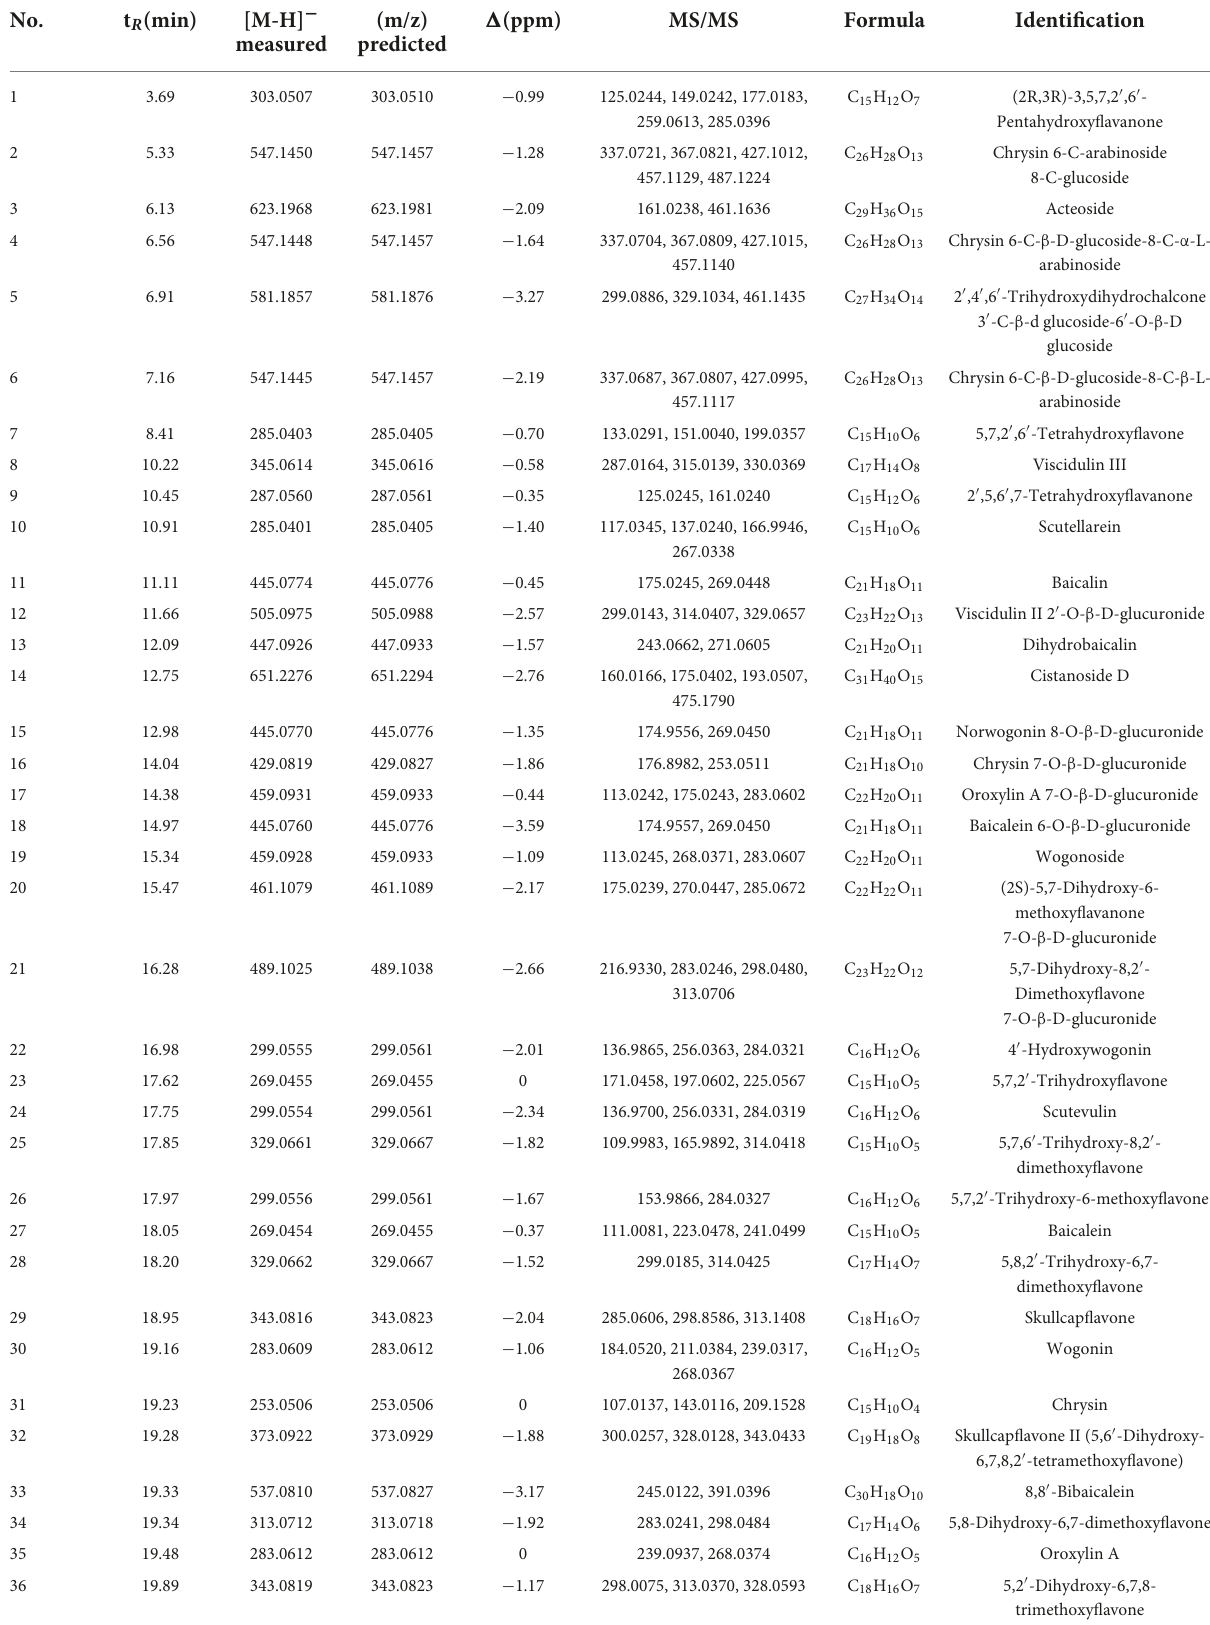
TABLE 1 Identification of compounds from Scutellariae radix extract by UHPLC-Q-TOF-MS.